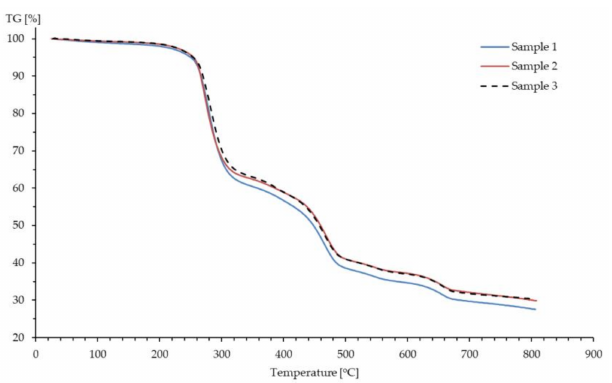
Figure 4. Thermogravimetry (TG) analysis for the ASR sample pyrolysis process.